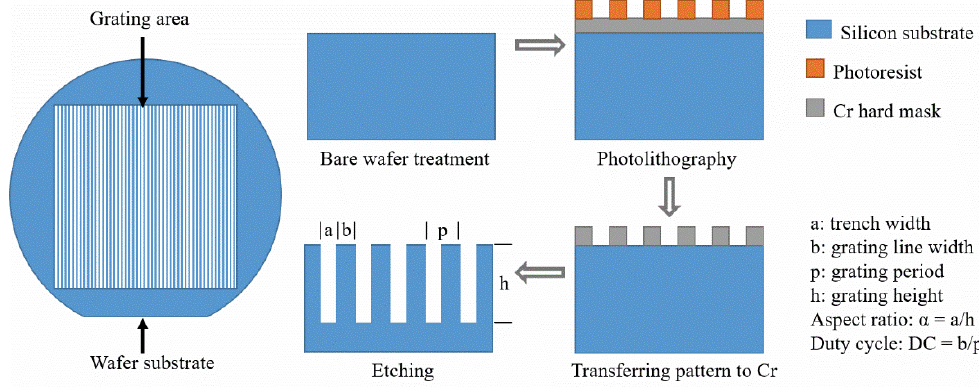
Figure 1. Process flow of silicon grating fabrication.